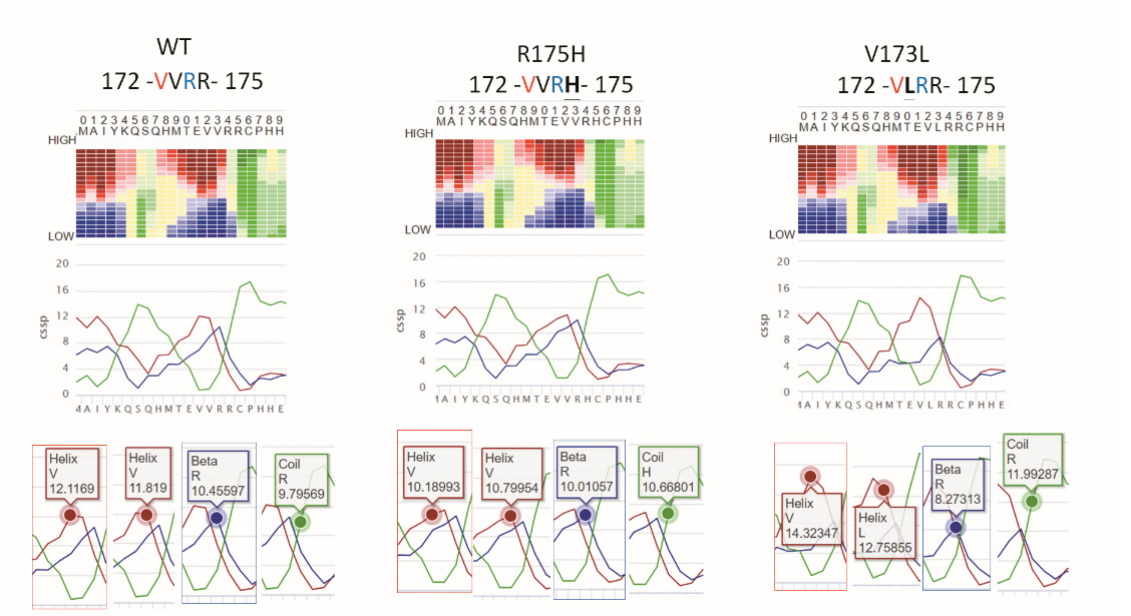
Figure 3. The CSSP value of the β -strand of flanking amino acids (a.a.) on p53 V173L is lower than the wild-type (WT) and R175H. The propensity for each of the three secondary structure elements, α helix (red), β -strand (blue) and coil (green), is calculated at 20 different levels, so the sum of the CSSP scores is 20. R175H flanking a.a. reduces α -strand CSSP from 12.1169 (WT) to 10.18993. V173L flanking a.a. reduces β -strand CSSP from 10.45597 (WT) to 8.27313. V173L flanking a.a. has a 14.32347 α -strand CSSP larger than WT (12.1169) and R175H (10.18993).